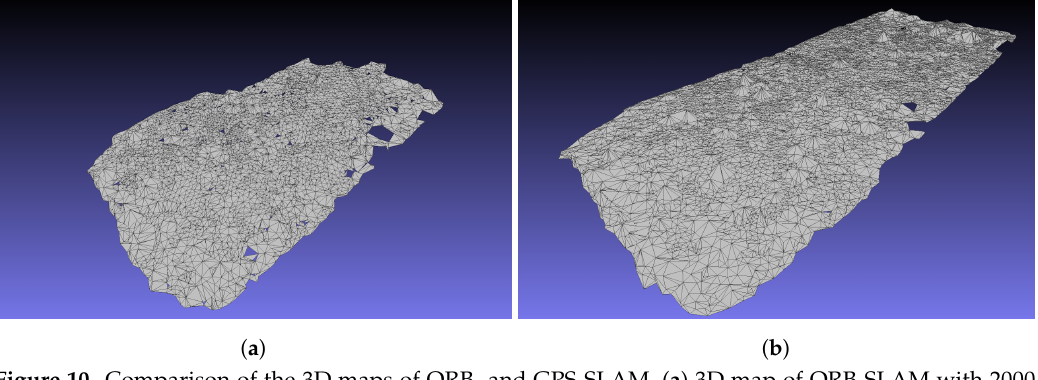
Figure 10. Comparison of the 3D maps of ORB- and GPS-SLAM. ( a ) 3D map of ORB-SLAM with 2000 features. ( b ) 3D map of GPS-SLAM with 6000